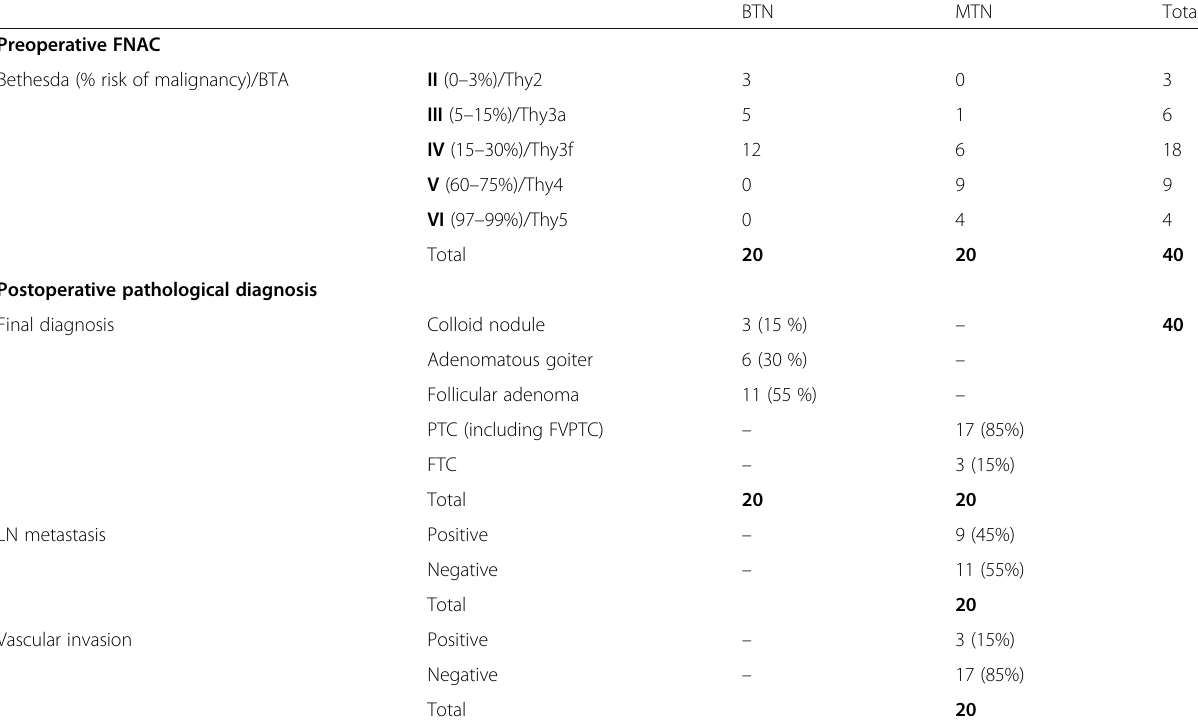
EGF, HGF, and MIG in differentiating BTN from MTN AUC of the different combination panels was compared showed the best AUC (0.858) (Fig. 1 and Table 4) Agreement and diagnostic performance analysis were conducted for the significant biomarkers individually and for the different combinations. Positive and negative status for each biomarker was determined according to its result, above or below the marker cut-off, respect- ively. In each biomarker combination, “ negative ” was assigned to the patient who was negative for all the markers of the combination (below the cut-offs) assigned Table 2 Preoperative fine needle aspiration cytology and postoperative pathological features of patients BTN MTN Total Bethesda (% risk of